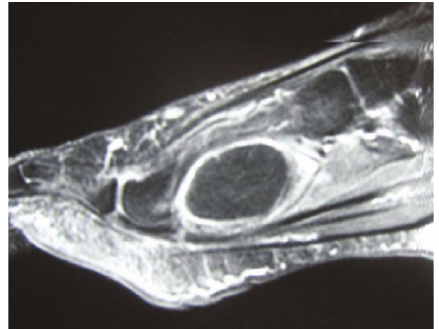
Figure 2: Sagittal gadolinium-enhanced MRI at admission.